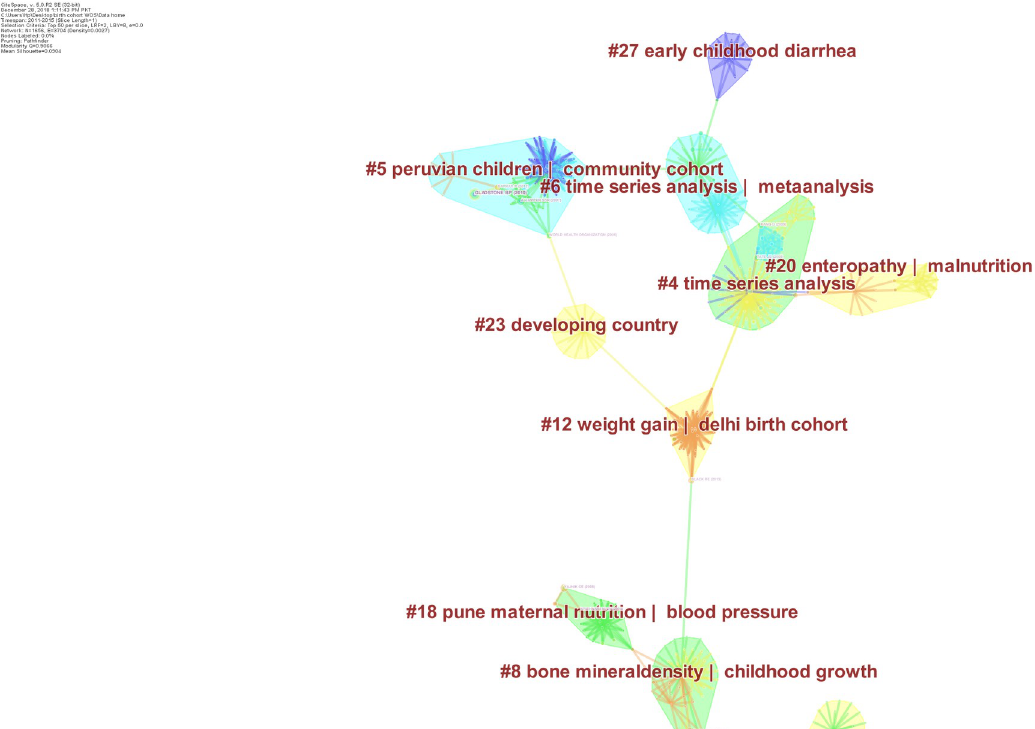
Fig 8. Research foci from 2011-2015b. This figure depicts major themes and foci of research output stemming from different birth cohorts established in South Asian Region, from 2011 to 2015. The shaded regions represent different clusters of research, labelled using indexed keywords. For instance, cluster # 4 represents research on time series analysis. Several nodes depicting number of citations as tree rings are shown to represent important entities. Purple coloured nodes represent landmark works that connect two clusters. Edges presenting relationship between two nodes are presented as lines. Different clusters are depicted with different colours.